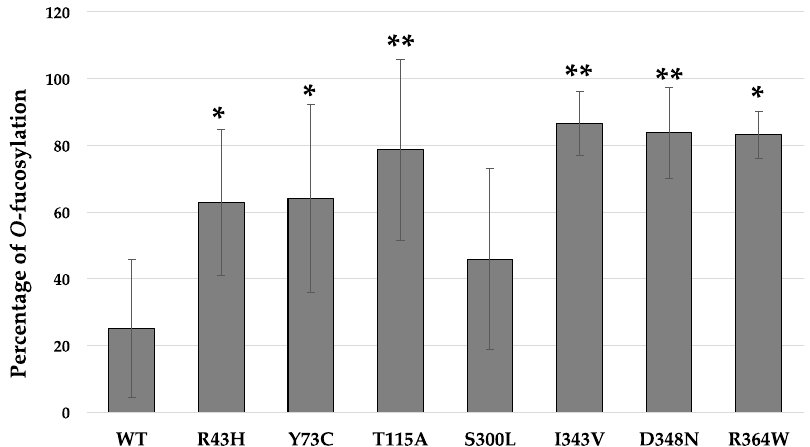
Figure 5. Quantification of the O -fucosyltransferase activity of WT POFUT1 and its seven mutated counterparts found in CRC patients. The percentage of O -fucosylation was determined from previous MRM-MS analyses based on ratios of peak areas of O -fucosylated peptides reported to those of total peptides. Bar graph represented mean of percentage ± SD. Each experiment was performed three times independently. Statistical significance was assessed using a two-tailed Student test; * p < 0.05, ** p < 0.01 vs. WT.